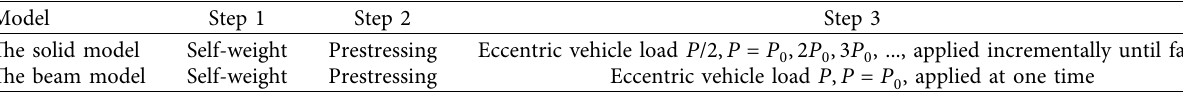
mm)Top surface of 3 to bottom surface of 7: contact, µ = 0.2 for GD bearings and µ = 0.03 for DX and SX bearings Side of 3 to side of 4: contact, µ = 0.2 Top surface of 2 to bottom surface of 3: contact, µ = 0.7 Top surface of 1 to bottom surface of 2: tie constraint